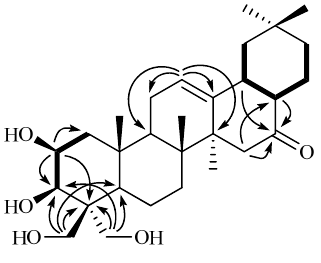
Figure 2. Key 1 H- 1 H COSY (bold lines) and HMBC (H → C) correlations of compound 1